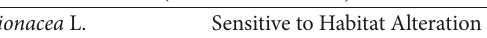
Table20:Speciesincludedintheregionalcatalogue(RC)ofNavarre (DEC. 94 /1997). RC of Navarre (DEC. Foral